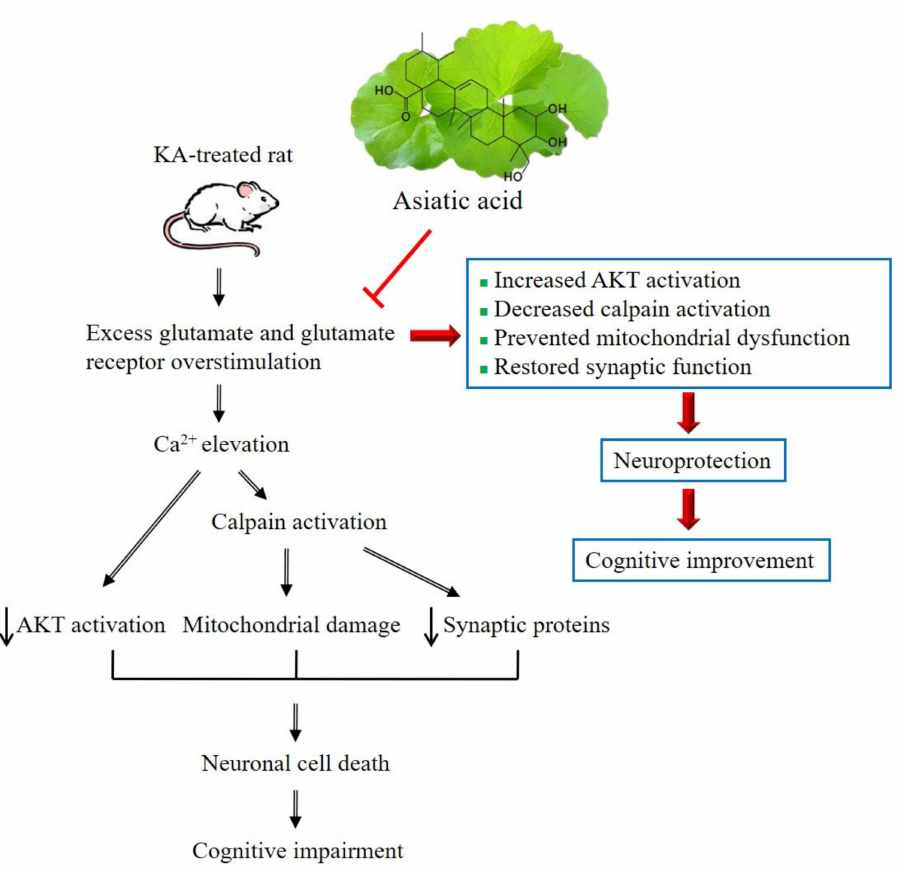
Figure 9. The proposed possible mechanisms underlying the cognitive improvement by asiatic acid in rats with KA-induced seizures. KA causes excessive glutamate release and consequent glutamate receptor overstimulation, resulting in Ca 2+ elevation, decreased AKT activation, increased calpain activation, decreased synaptic proteins, mitochondrial damage, and eventually neuronal damage and death, which may contribute to cognitive deficits. Asiatic acid, through inhibiting glutamate release, can effectively inhibit calpain activation, increase AKT activation, and preserve synaptic and mitochondrial function, thus contributing to the improvement of the cognitive dysfunction of rats with KA-induced